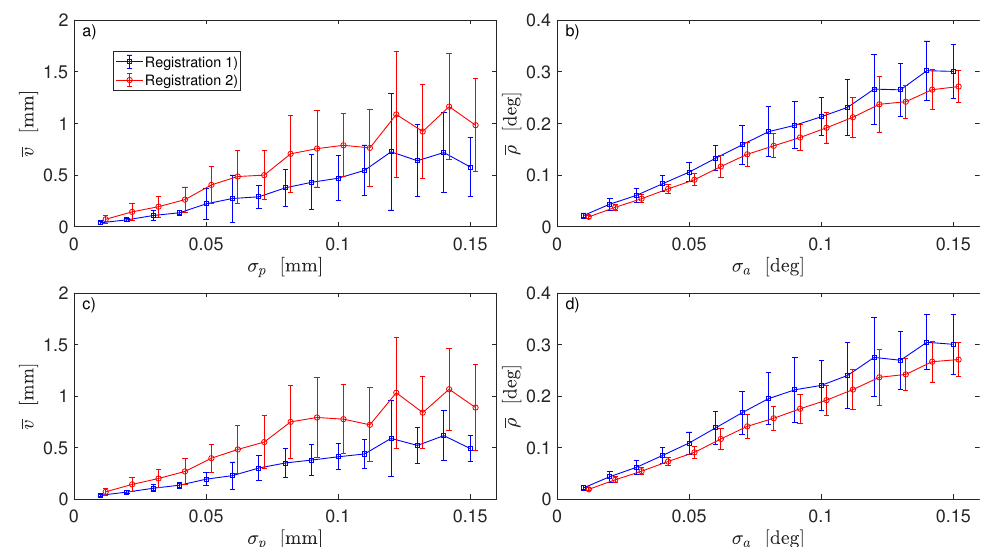
Figure 3. Comparison of two registration procedures for robot calibrated with Method 2 and data generated using: ( a , b )—small deviations from the default DH parameters ( ∆ α 1 , ∆ r 1 , ∆ d 1 ) ; ( c , d )— large deviations ( ∆ α 2 , ∆ r 2 , ∆ d 2 ) . Dependence of the mean positional error v of robot end-effector on positional noise σ p in sensor 6D data in ( a , d ); dependence of the mean orientation error ρ of robot end-effector on angular noise σ a in sensor 6D data in ( b , d ).